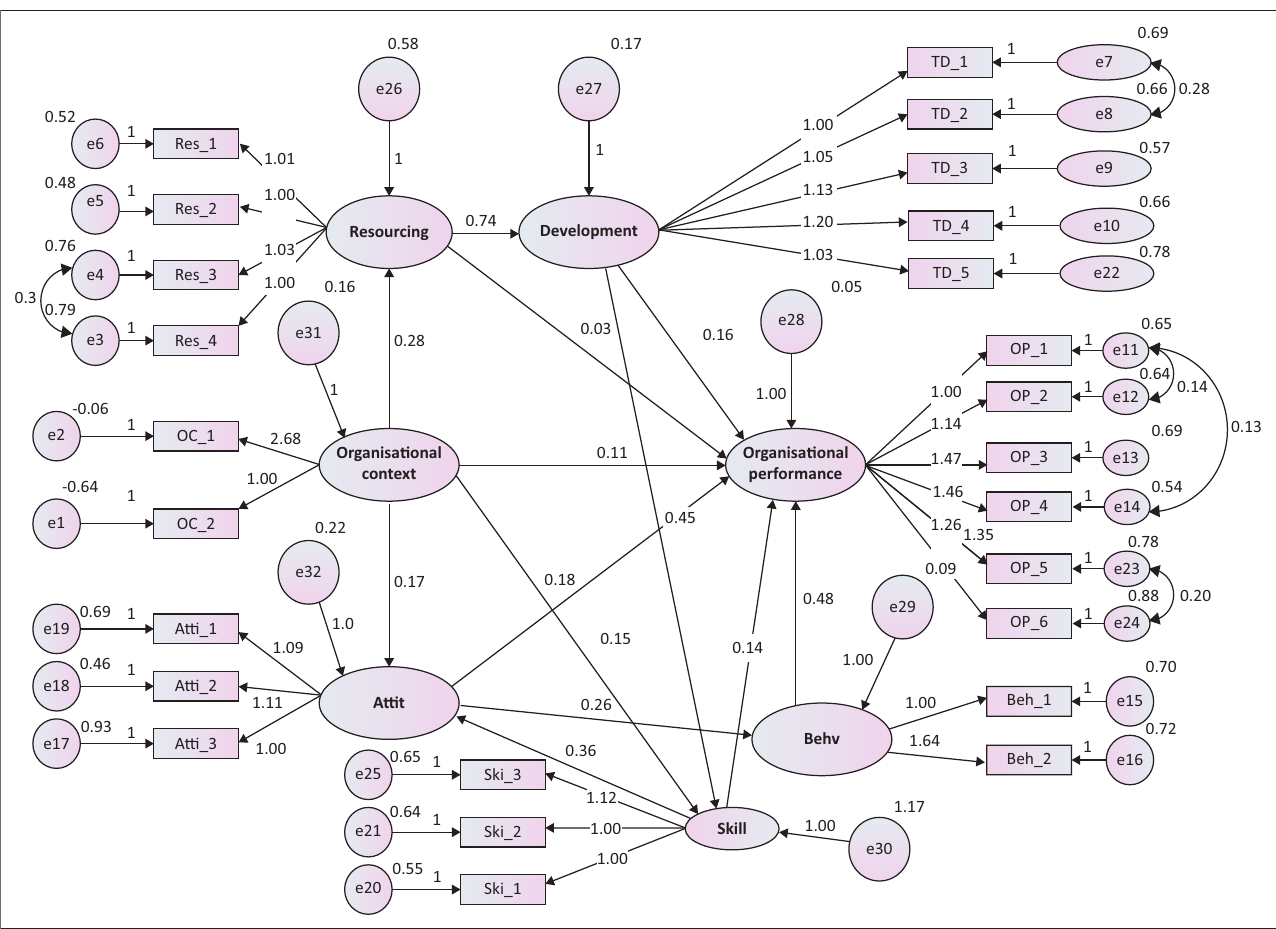
FIGURE 1: The operational human resource management–performance linkage casual model.